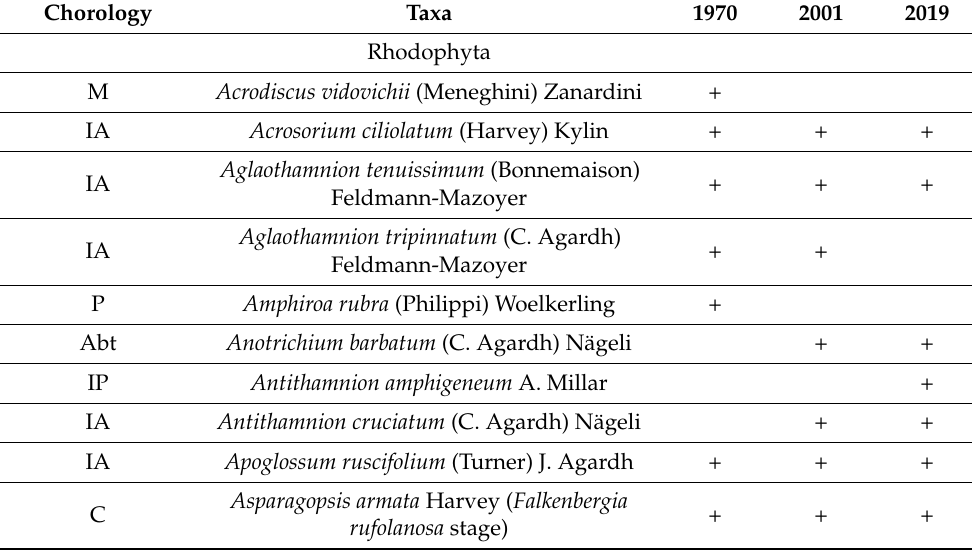
Table 2. List of the macroalgal taxa found in the 1970s, 2001, and 2019 in the coralligenous habitat of the MPA Isole